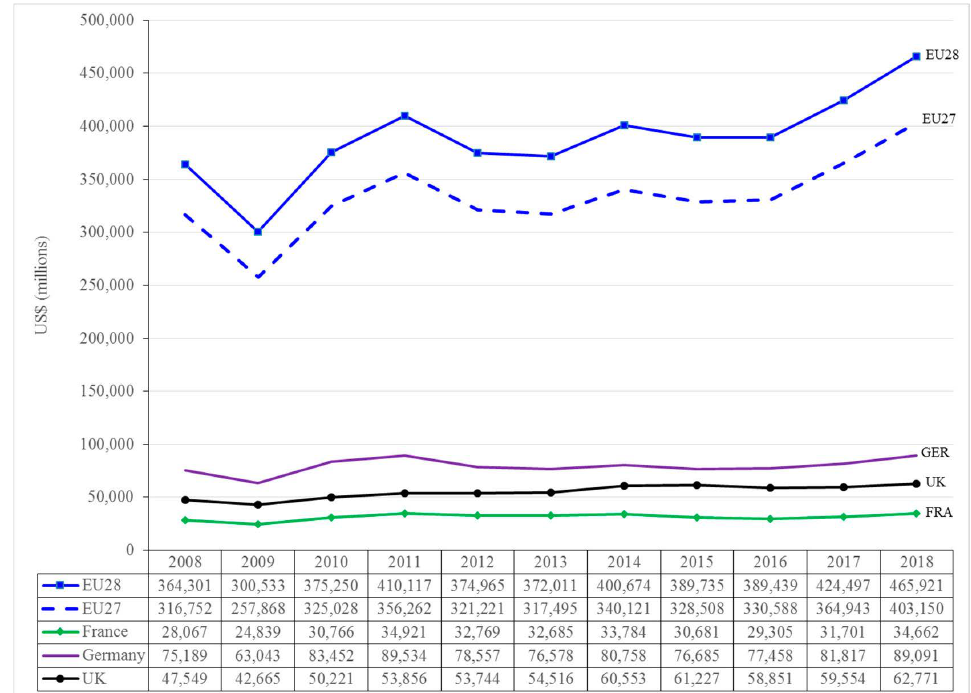
Goods imports from China (US$ [millions]), 2008–18. Source: International Monetary Fund, ‘Direction of Trade Statistics’ (2020) <http://data.imf.org/?sk=9D6028D4-F14A-464C-A2F2-59B2CD424B85>